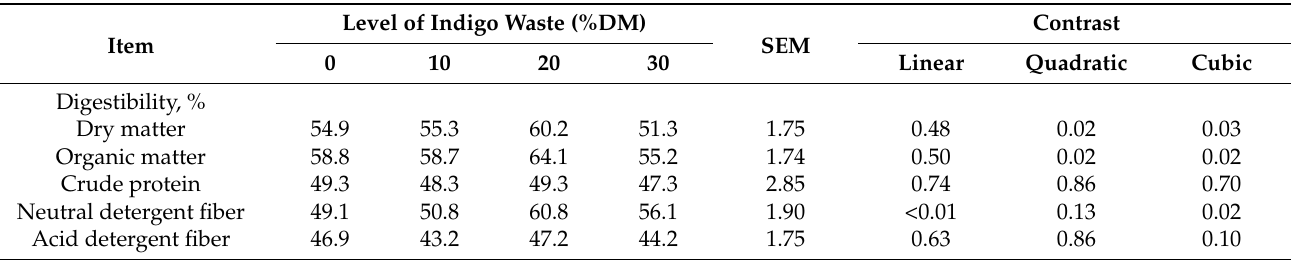
Table 5. Effect of indigo waste on nutrient digestibility in growing beef